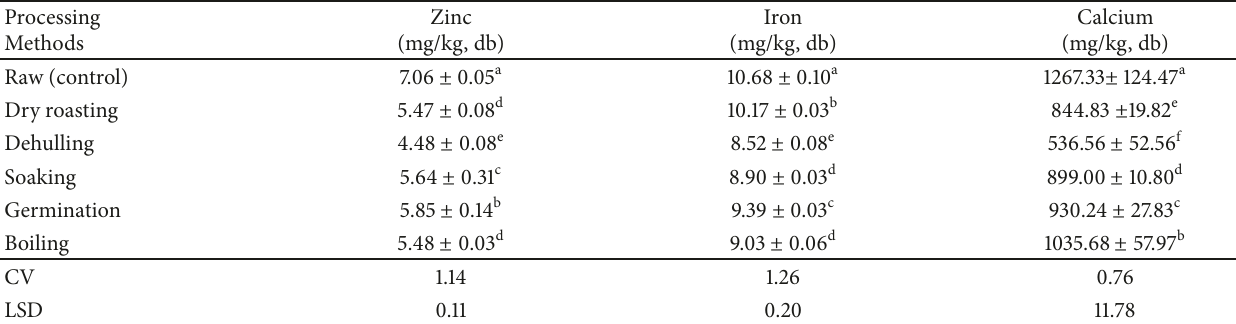
Table 3: Effects of processing methods on mineral composition of improved chickpea varieties.